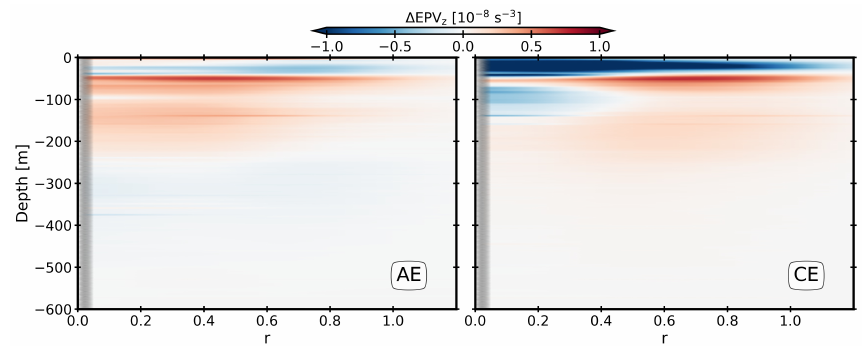
Figure 21. The vertical component of the EPV anomaly for the CE and